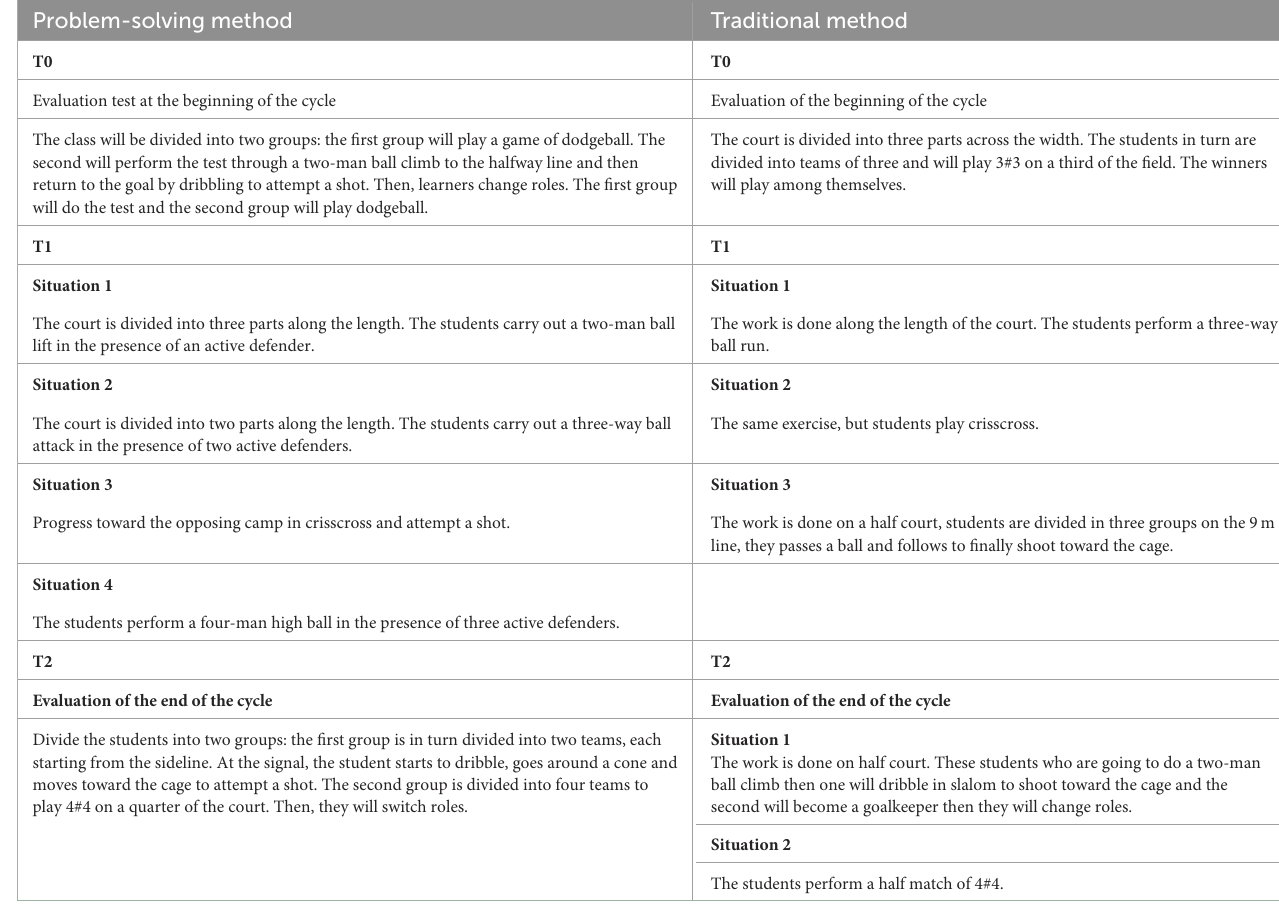
TABLE 1 Example of activities for the different